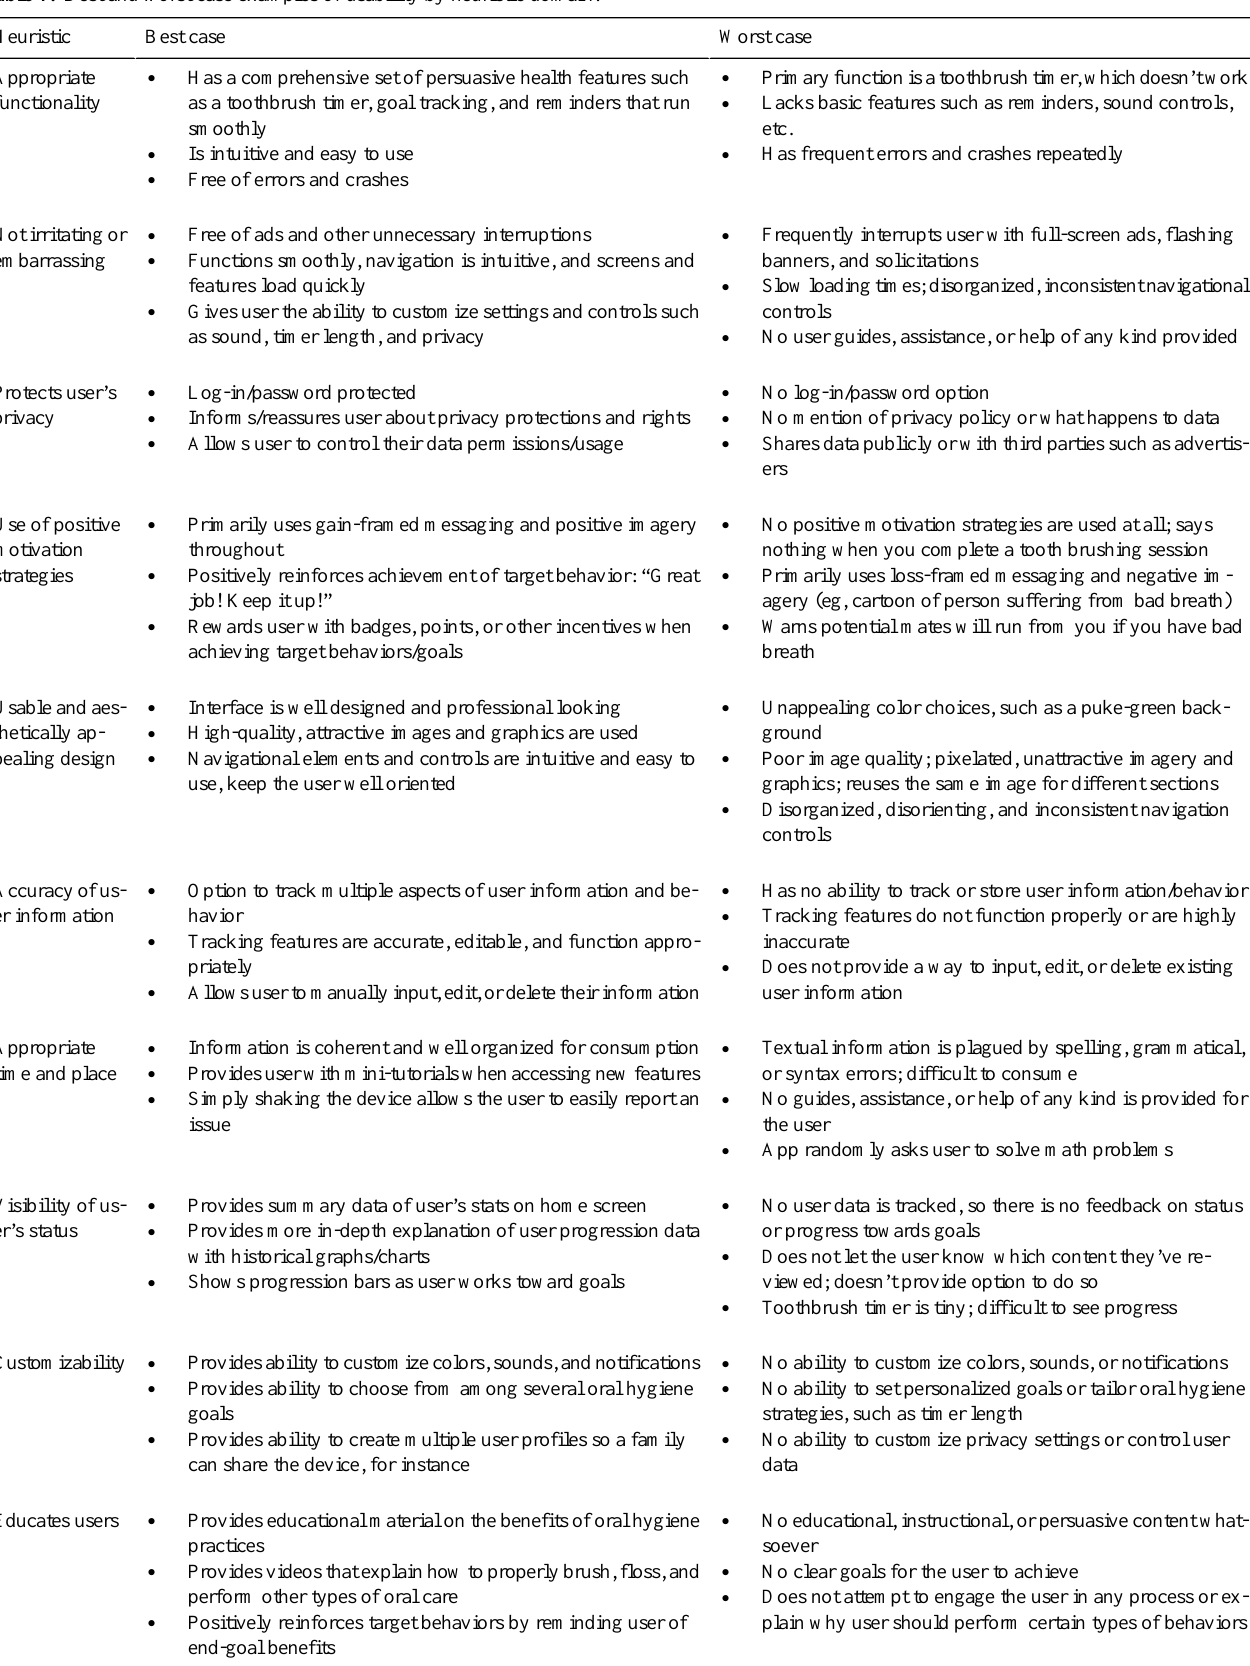
Table 1. Best and worst case examples of usability by heuristic